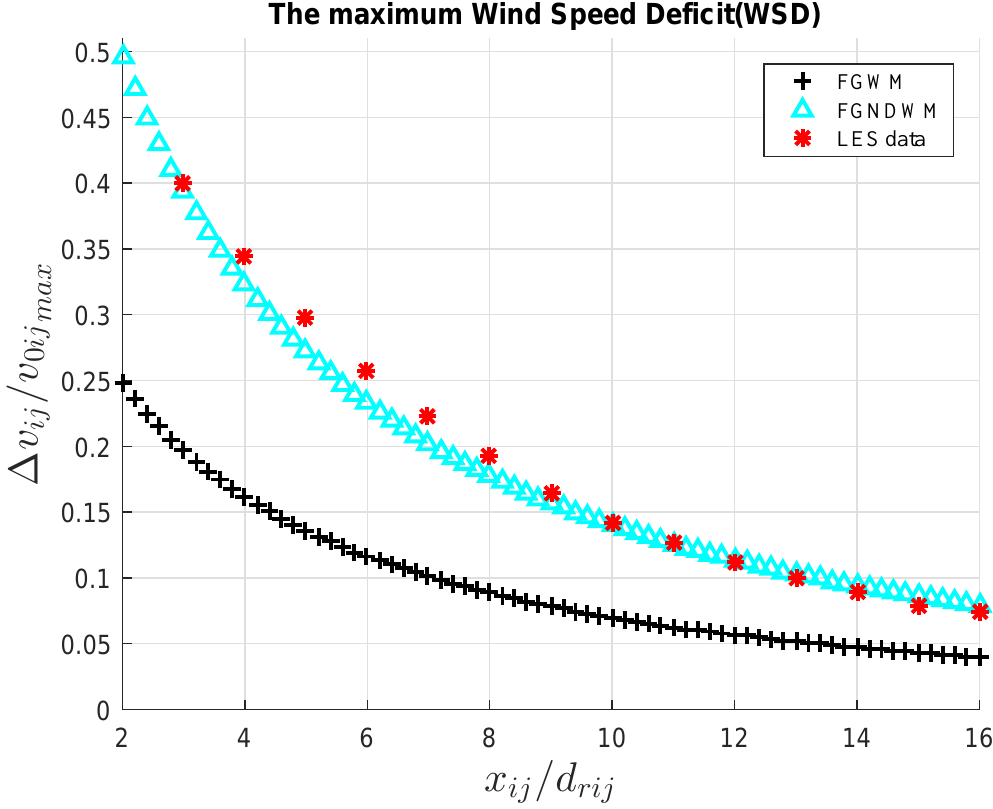
Figure 5. The portrait of the maximum Wind Speed Deficit (WSD) in Case a (fitted by LES data, i = 1,2, · · · , N ; j = 1,2, · · · , N